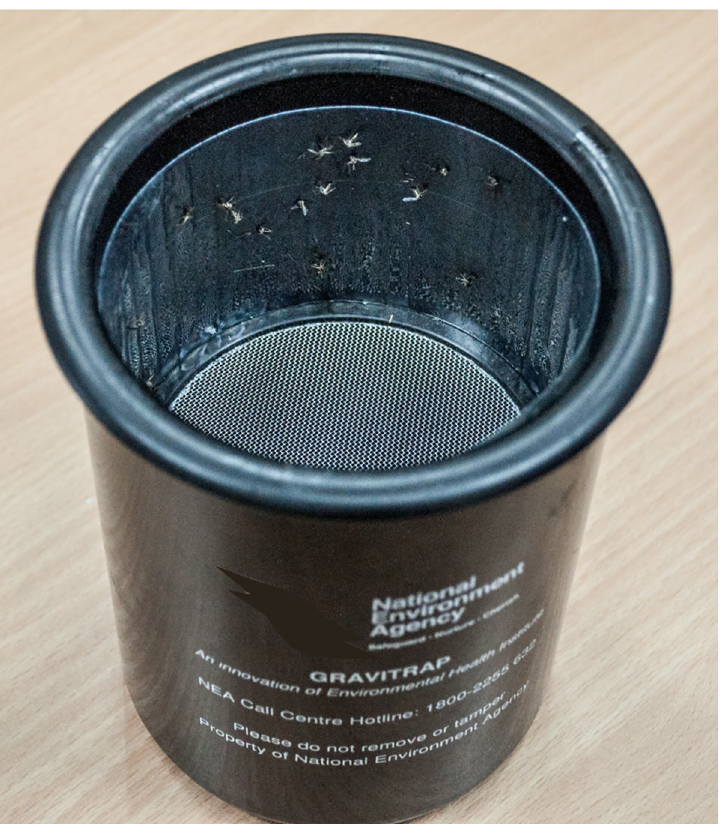
Fig 1. Photo of a Gravitrap with mosquitoes trapped on the sticky